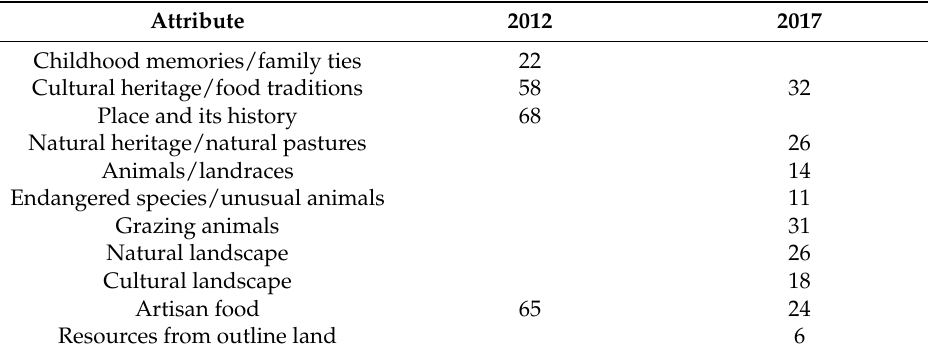
Table 4. A summary of post-modern and environmental attributes 1,2